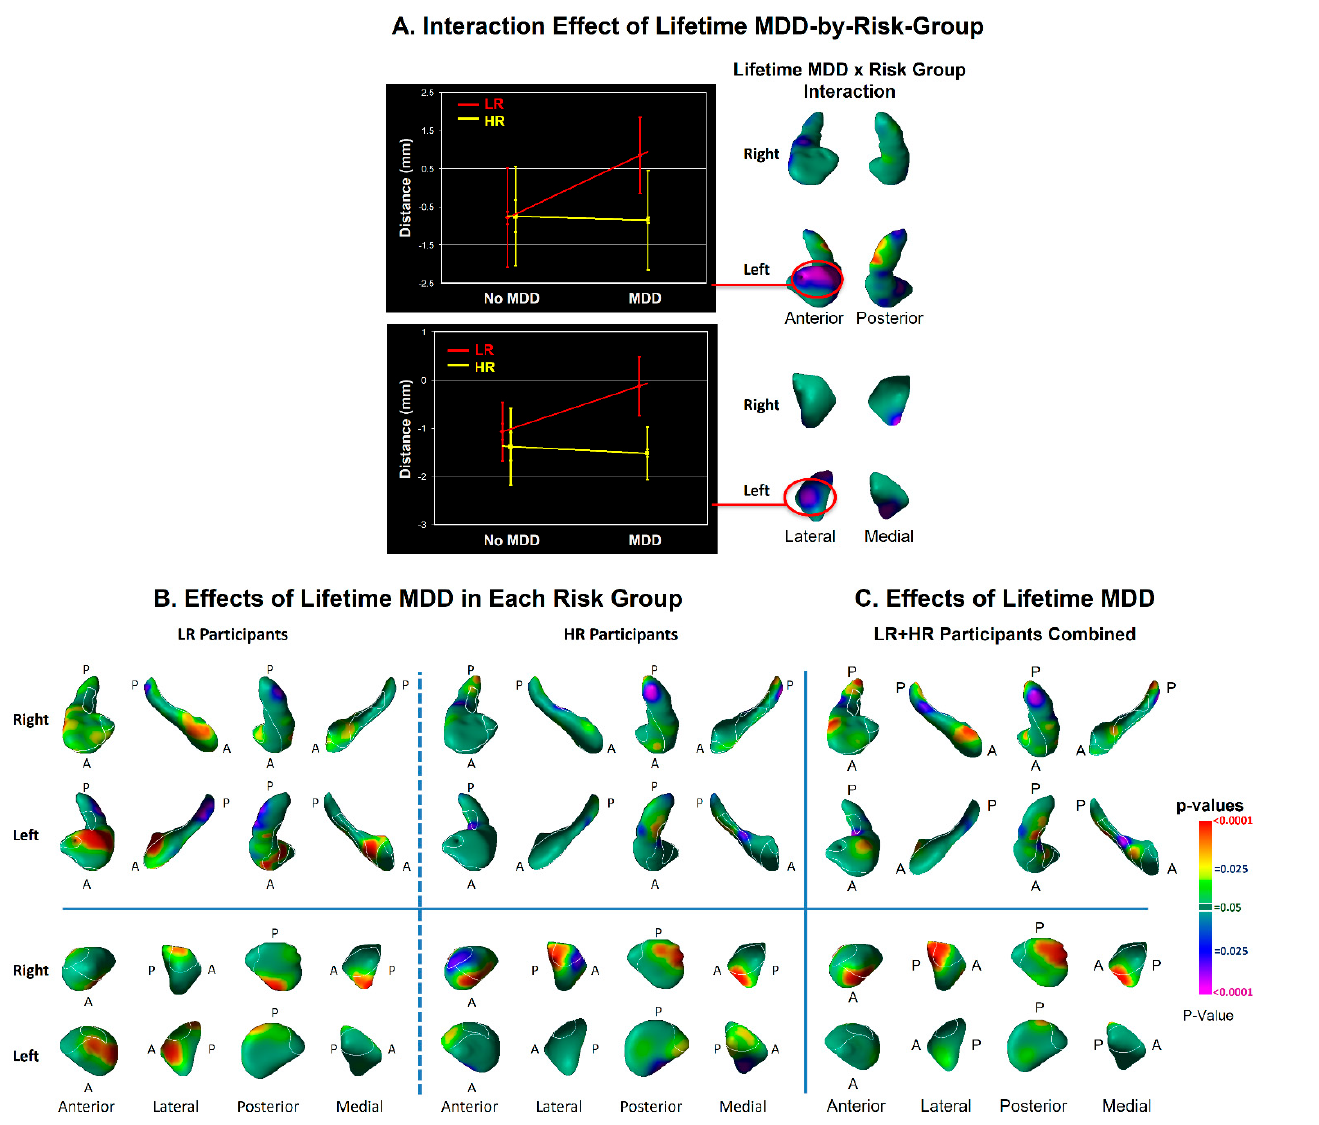
Figure 5. Effects of Lifetime Depressive Illness on Surface Morphologic Features. Panel ( A ): The effect of the lifetime MDD-by-risk-group interaction on surface morphological features is shown in the lateral and medial views of each hippocampus and amygdala. The interaction is plotted for representative points of the left hippocampus and left amygdala where this interaction is statistically significant, showing that the interaction derives from relative protrusions in the surface of low-risk (LR) participants at those locations. Panel ( B ): The effects of lifetime MDD are shown for high- and low-risk groups separately to help further understand the significant interaction of risk group with lifetime illness shown in Panel A. The statistical model included the main effect of lifetime MDD and the covariates of age, age 2 , and sex. Lifetime illness was associated in both risk groups (HR N = 81, LR N = 67) with inward deformations in the tail and body of the hippocampus, but the low-risk participants also had associations with prominent protrusions in the head of the left hippocampus and lateral surface of the left amygdala. Panel ( C ): The main effect of lifetime MDD is shown for both LR and HR groups combined. The statistical model included lifetime MDD, risk group, age, age 2 , and sex. lifetime MDD was associated in both risk groups with protrusions in the dorsolateral head and indentations of the tail of both hippocampi, and with protrusions in posterolateral and anteromedial surface of the right amygdala. Most of the protrusions of the right amygdala associated with lifetime MDD were also present in similar locations for the effect of risk group (Figure 2).